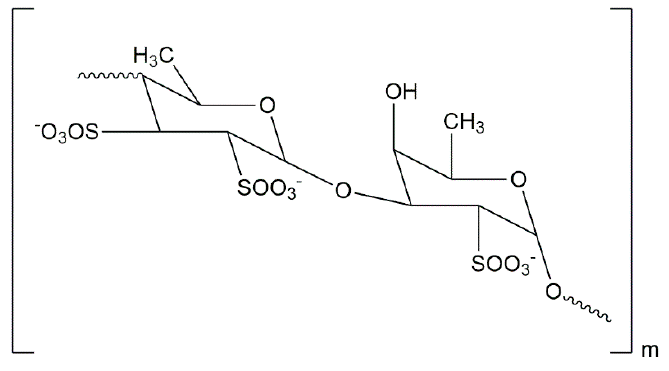
Figure 3. Fucoidan structure [77].